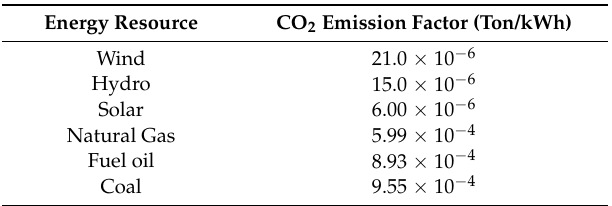
Table 1. CO 2 emission factor “ α ” for different energy resources